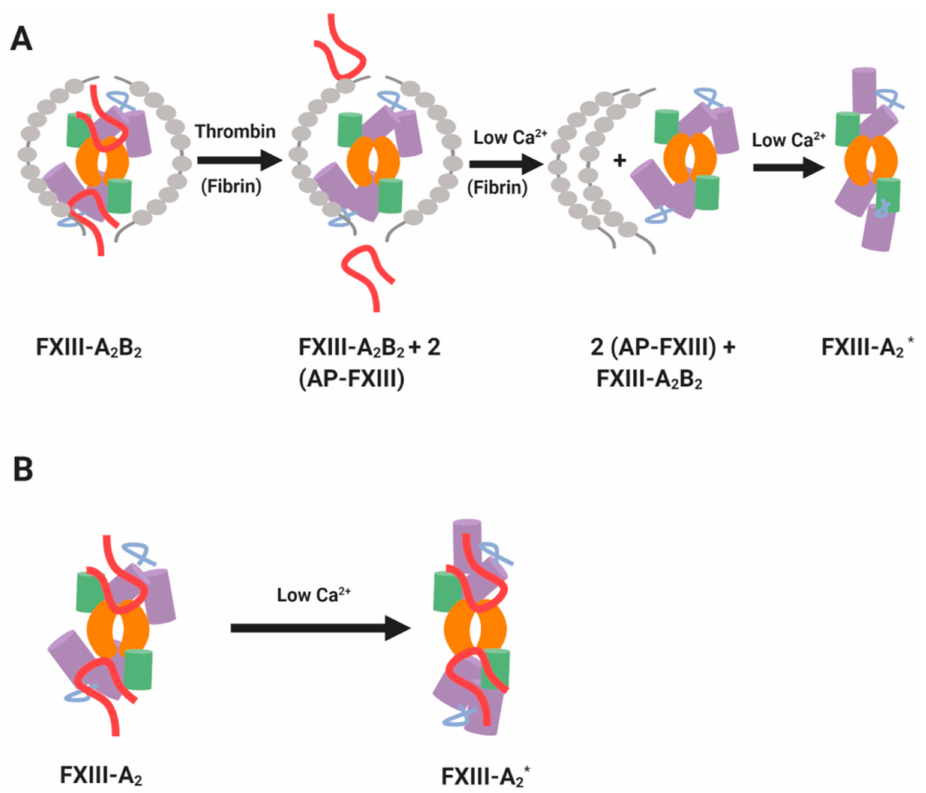
Figure 1. Mechanisms of FXIII activation. ( A ) Thrombin- and Ca 2+ -driven cleavage of FXIIIA 2 B 2 . ( B ) Non-proteolytic activation of cellular FXIII-A by low Ca 2+ . The green and purple cylinders represent β -barrel and β -sandwich domains of FXIII-A subunit, respectively. The core domains in FXIII-A subunit are shown in orange and the activation peptides are shown in red. The inhibitory B subunits are shown in grey. Adapted from the work in